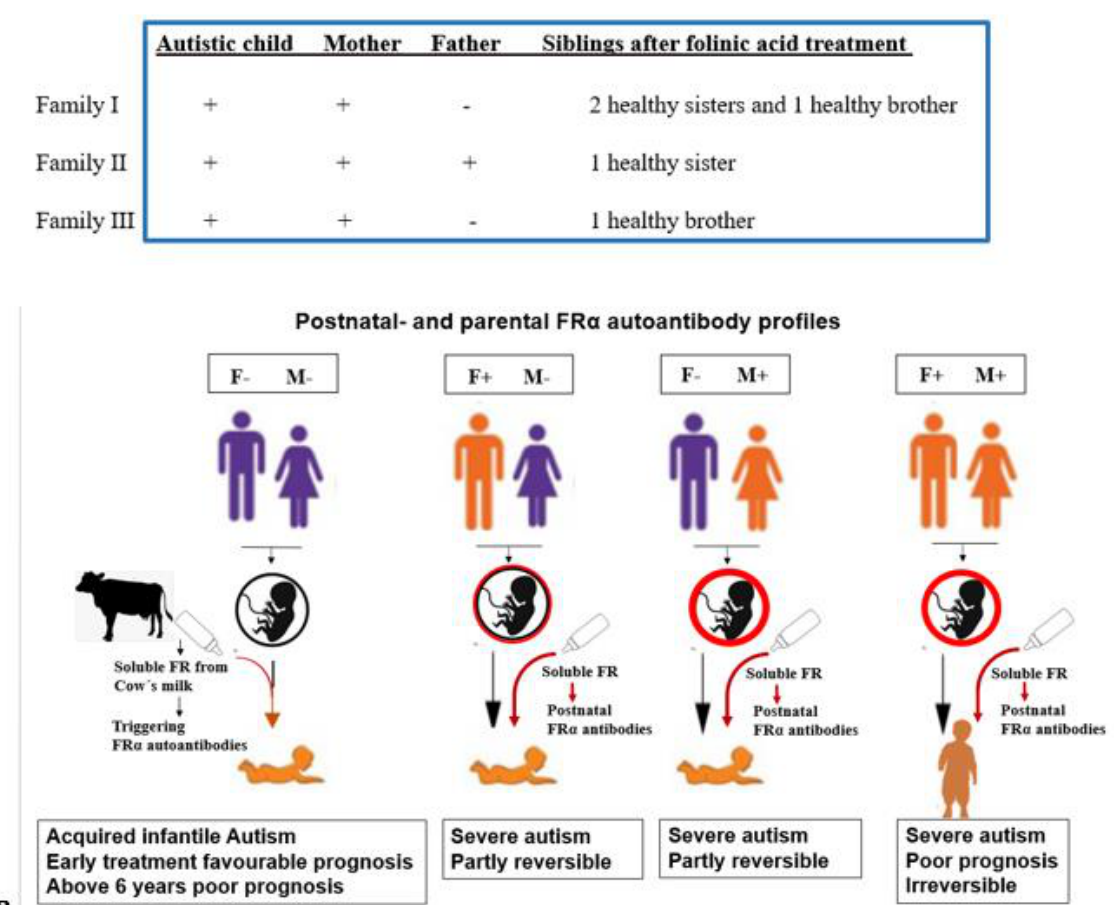
Figure 6. ( A ). Genetic counseling FR α Ab testing for first child with autism and parents to prevent the reoccurrence of autism in further offspring. ( B ). Various situations with positive FR α autoanti- bodies in child and parents.